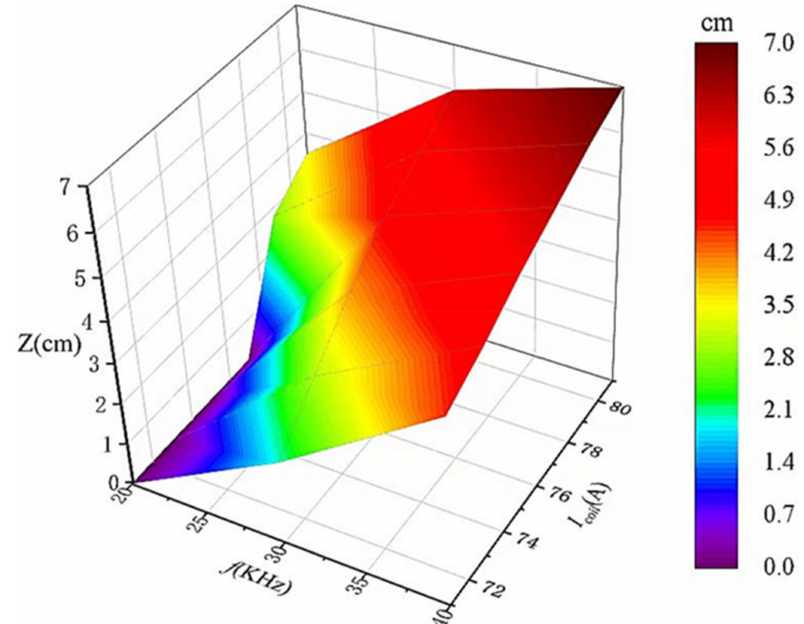
Figure 9. The variations in Z with current and